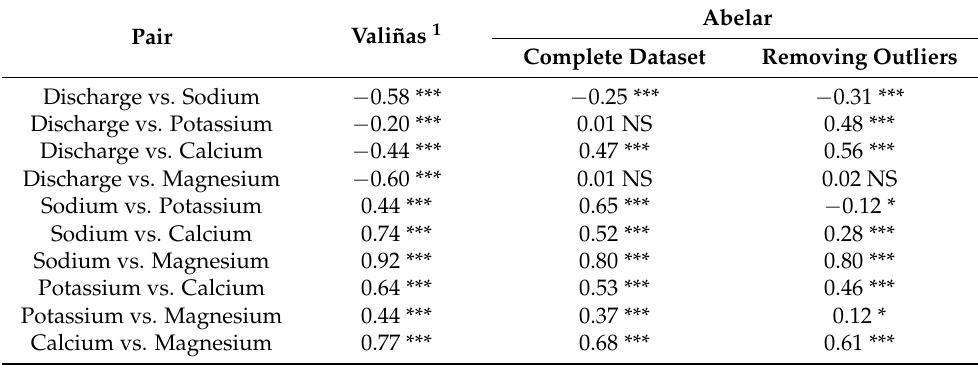
Table 2. Pearson’s r correlation coefficients among discharge and solute concentrations for the whole dataset from each of the two studied catchments (Valiñas and Abelar). In the case of Abelar, the correlations are shown for both the entire dataset and by removing a single outlier. Abelar Pair Valiñas 1 Complete Dataset Removing Outliers Discharge vs. Sodium Discharge vs.